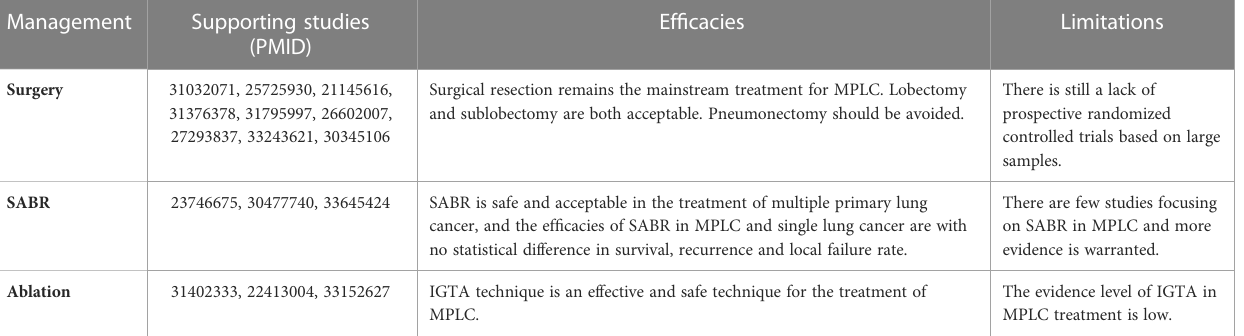
TABLE 2 Summary of MPLC clinical managements.